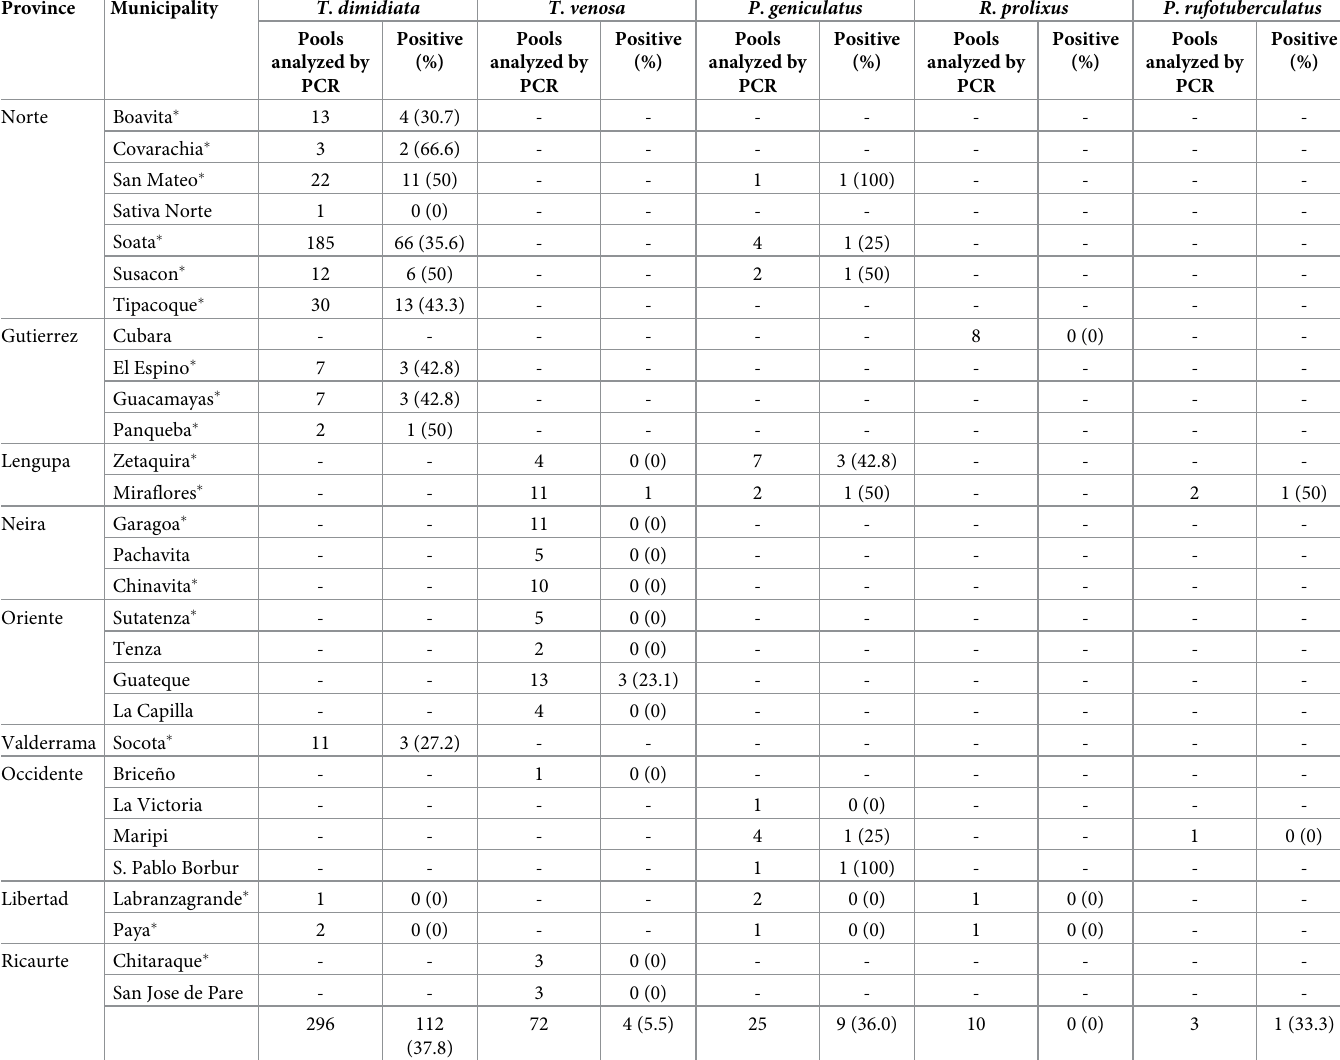
Table 2. T . cruzi infection rates evaluated in triatomines collected in the 29 infested municipalities in Boyaca department (Colombia), from March 2017 to Novem- ber